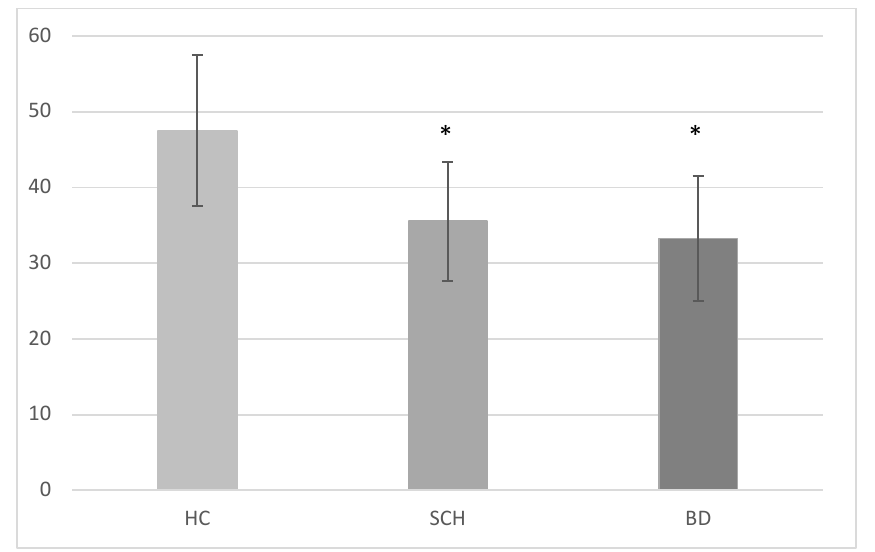
Figure 2. Mean score on total task by group. * Healthy control group > schizophrenia group = bipolar group.